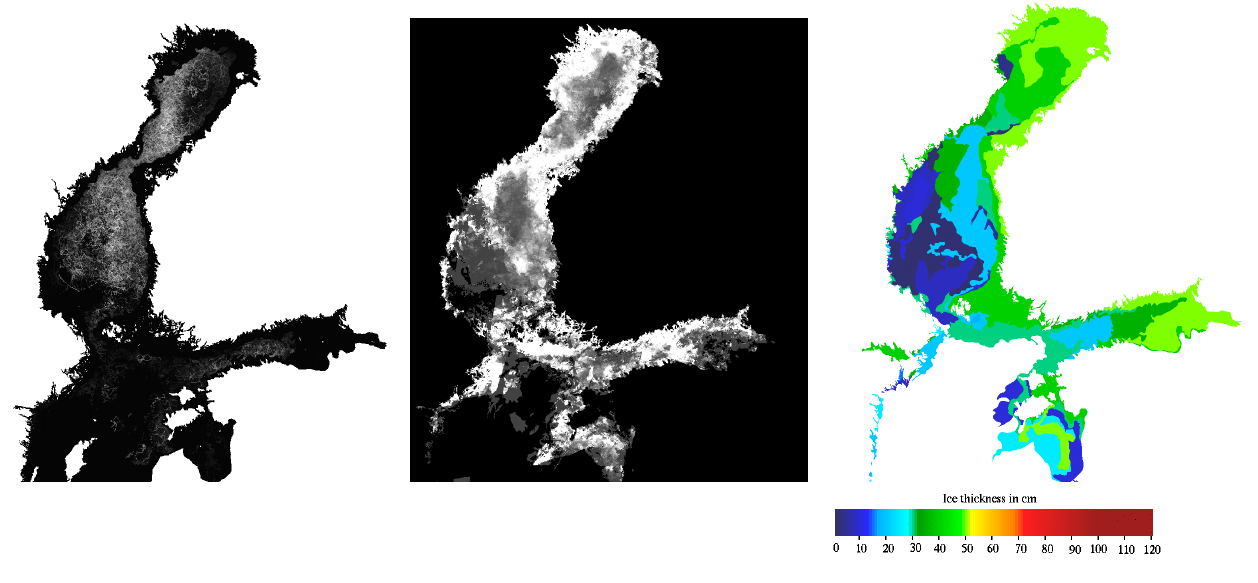
Fig. 6. Ice total deformation (left), ice motion ratio (middle), and the mean level ice thickness on 17 March 2011. The total deformation and ice motion ratio are computed over two weeks before 17 March, and the brighter tones indicate higher values.